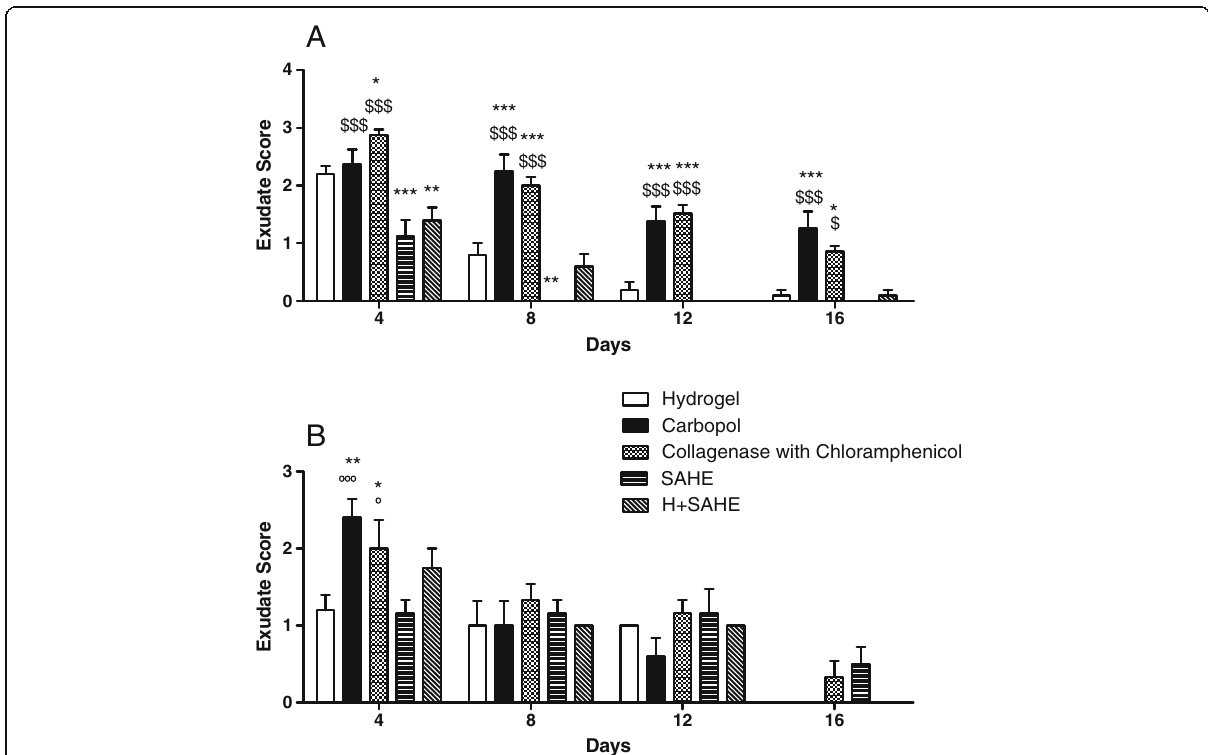
Fig. 4 The exudate scores of the cutaneous wounds in the non-diabetic animals ( a ), and in the diabetic animals ( b ), on days 4, 8, 12, and 16. Each column represents the mean ± standard error of 4 – 6 animals. *p < 0.05, **p < 0.01, *** p < 0.001, represents the level of significance when compared to the Hydrogel group; $ p < 0.05 and $$$ p < 0.001 when compared to the H + SAHE group; and °p < 0.05 and °°p < 0.001 when compared with the SAHE group (Two-Way Analysis of Variance, followed by Bonferroni ’ s